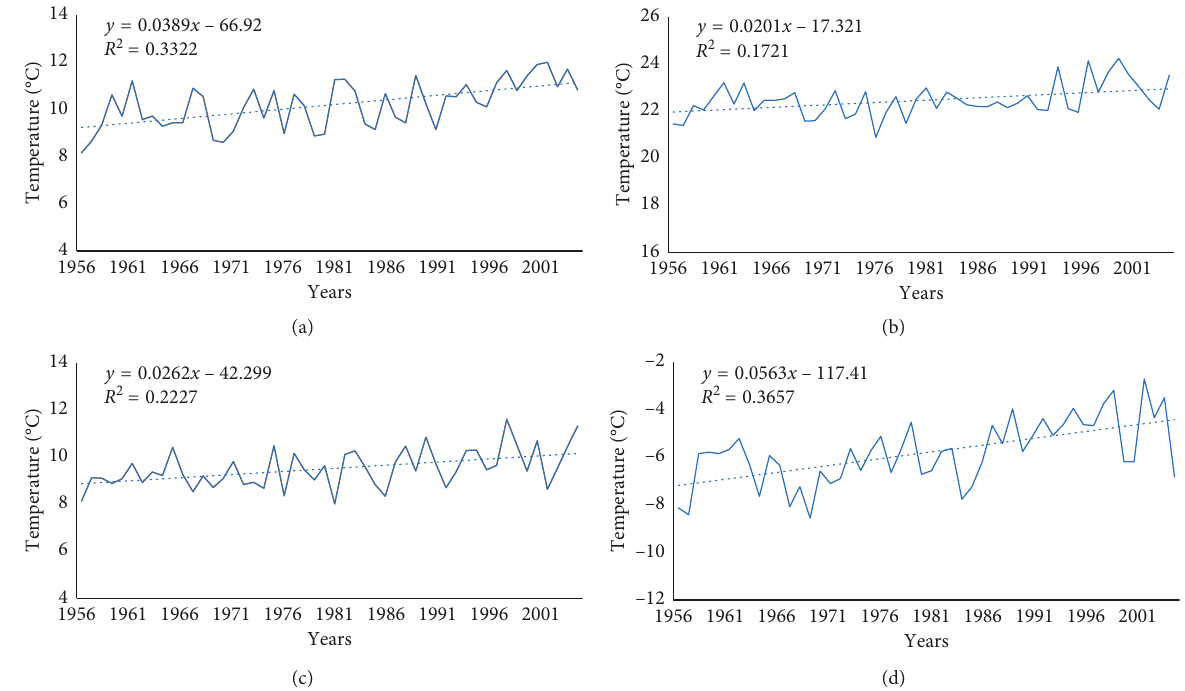
Figure 4: Interannual variation of seasonal mean temperature in the Beijing-Tianjin-Hebei region from 1981 to 2010: (a) spring; (b) summer; (c) autumn; (d)